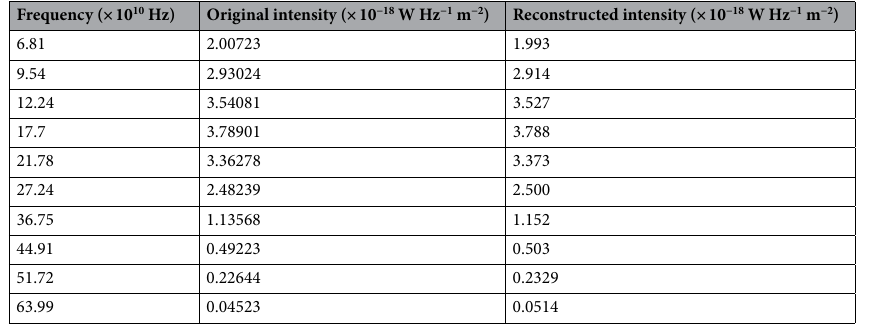
Table 2. All the values of original and reconstructed intensities for the monopole are